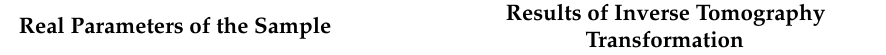
Table 2. Comparison of results of inverse eddy current transformation with real parameters of the